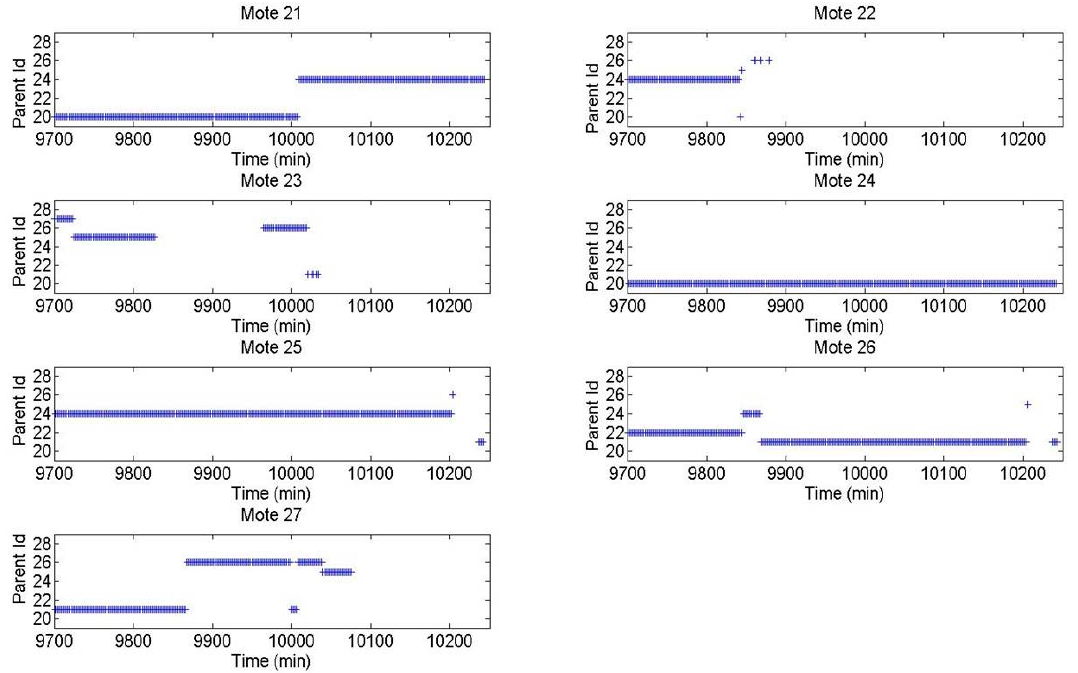
Figure 13. Parent identifiers of each message using the CTP protocol during the last period of the WSN lifetime in Experiment 1.